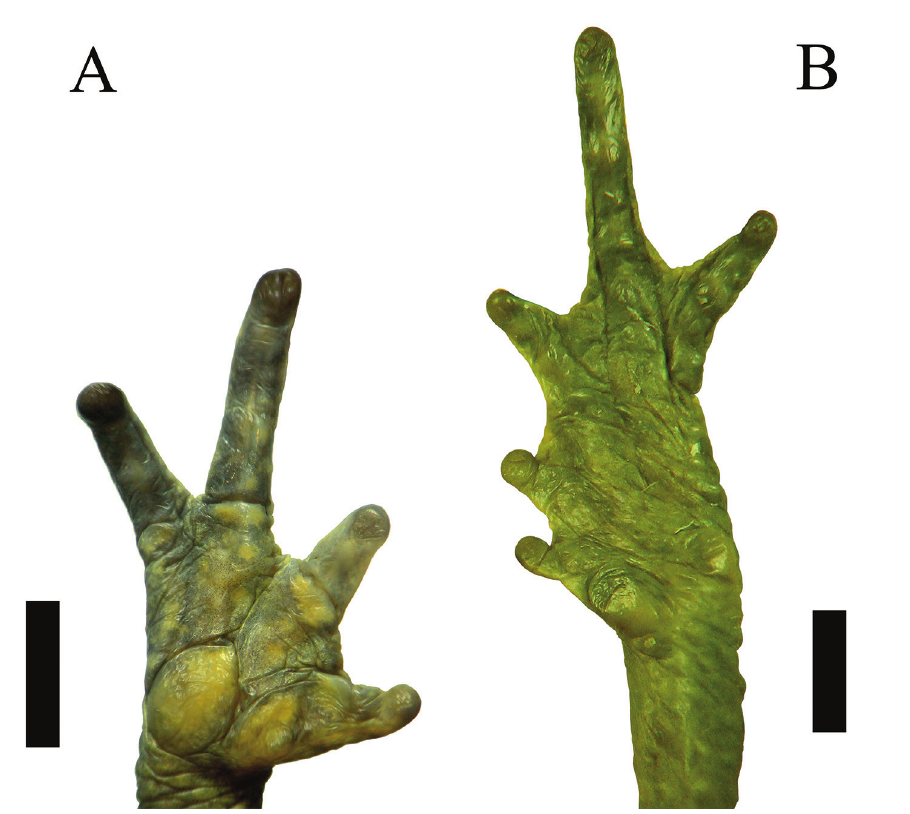
Figure 4. Holotype of Rhinella lilyrodriguezae sp. n. (MUSM 32204), A palmar, and B plantar views of right hand and foot. Scale bar 5 mm. Photos by Juan C. Cusi. opening directed posteriorly at the mid-level of the thighs); tongue narrow, about 2.5 times as long as wide, not notched posteriorly, posterior one half free; choanae small, ovoid, widely separated and partially concealed by palatal shelf of maxilla. Measurements (in mm) of the holotype. SVL: 58.3; HW: 17.8; HL: 15.9; ED: 4.4; IOD: 9.3; EW: 3.9; EL: 6.4; IND: 4.3; E–N: 5.8; NSD: 3.2; SL: 9.1; FL: 15.4; HNDL: 16.3; FEML: 23.7; TL: 23.4; FOOTL: 22.6. Coloration of the holotype in alcohol (Fig. 5). General dorsal coloration light brown; dorsum and hind limbs with small, irregular, dark brown spots and mark- ings; flanks cream, with a discontinuous, well defined, broad, black ventrolateral band beginning behind tympanum and extending to inguinal region; dark grey transverse bars on shanks; tympanum brown; upper lip cream without bars or spots; dorsolateral row of tubercles reddish brown, sharply contrasting with the black discontinuous ven- trolateral band; throat, chest and venter gray with minute light cream spots; ventral surfaces of thighs gray with minute dark grey spots; ventral surfaces of hands and feet dark gray; subarticular and supernumerary tubercles cream on